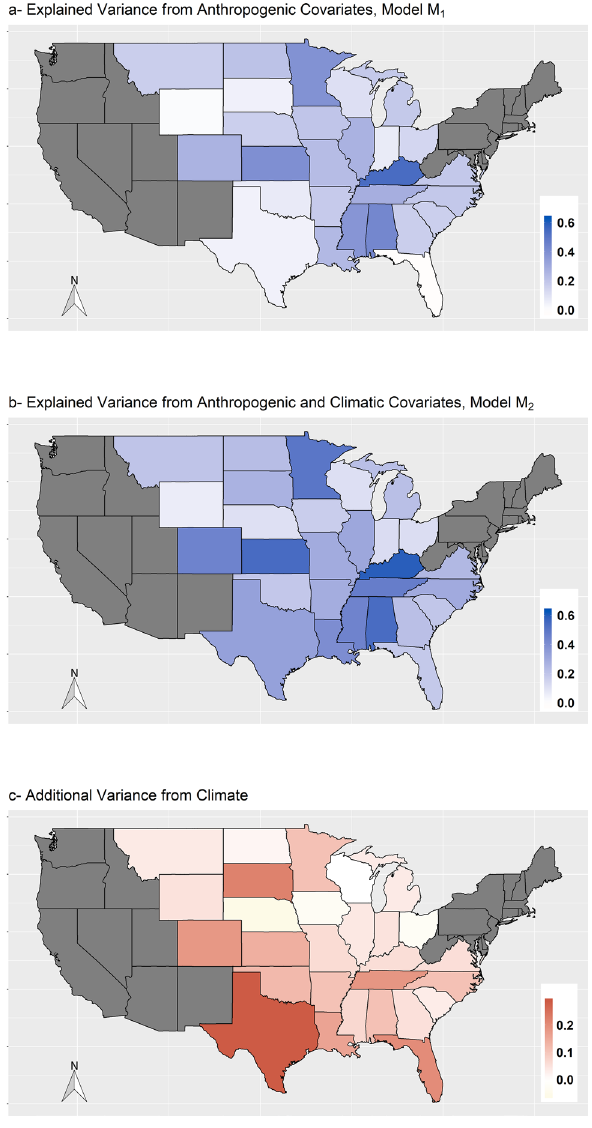
Figure 3. Spatial distribution of the explained variance from the nested models (M 1 and M 2 ). The explained variance, i.e., R 2 , is calculated based on sum of squared residuals, R observed and the predicted posterior median of the tornado counts in year t and state i , and the observational data during the entire period. (Maps are created in R version 3.5.2 using the ggplot2 package 32 , https ://CRAN.R-proje ct.org/packa ge=ggplo